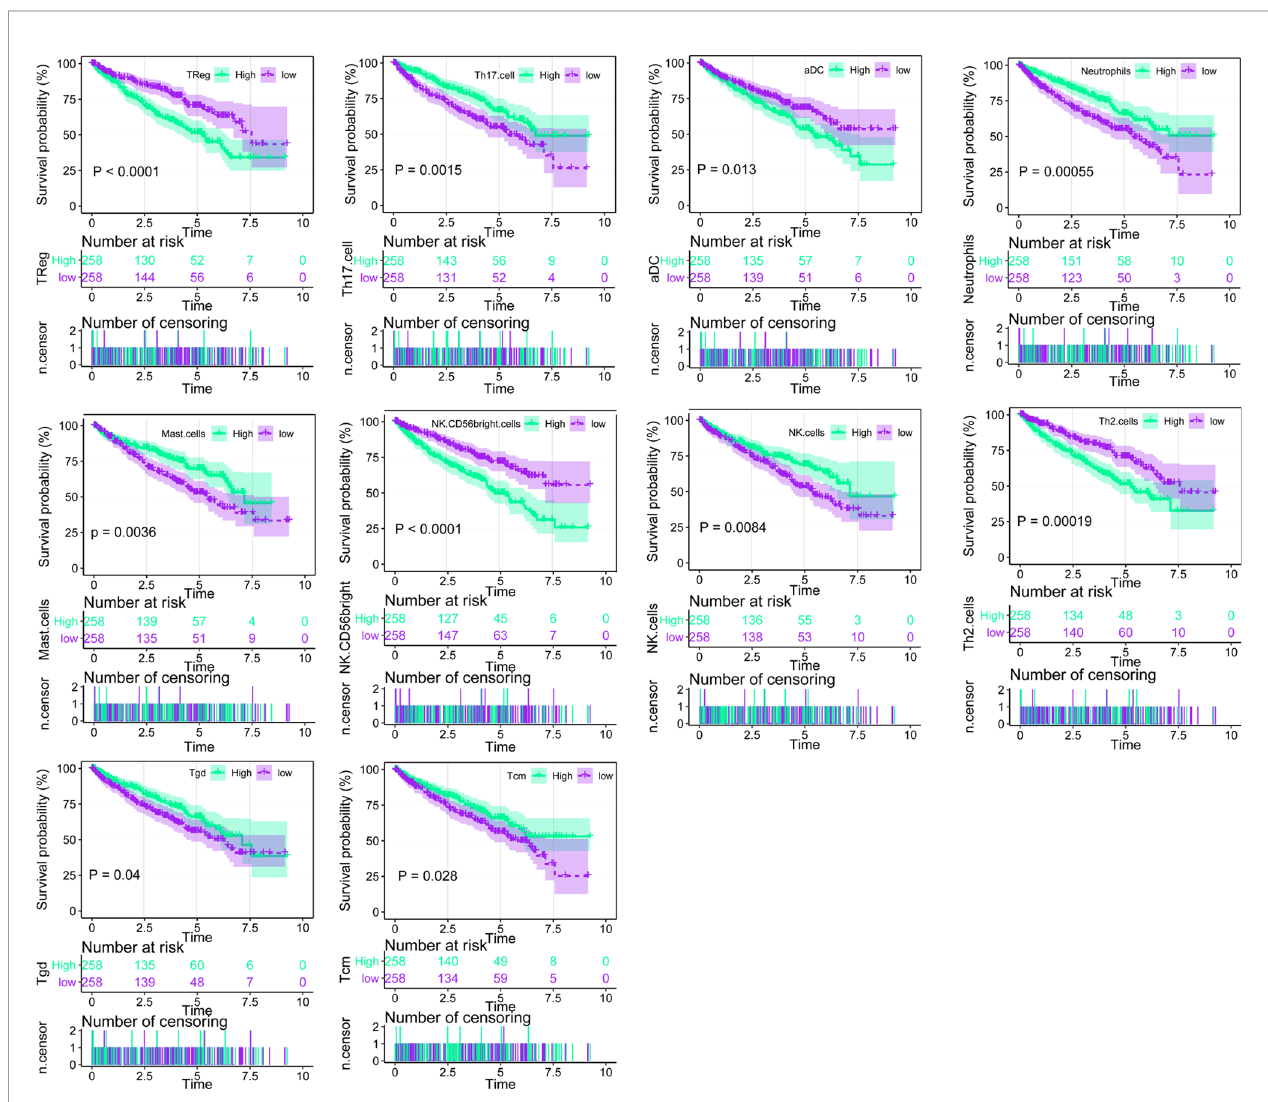
FIGURE 1 | Overall survival analysis of the 24 immune cells based on median scores calculated by ssGSEA, the score higher than the median score was considered high, while lesser score was considered